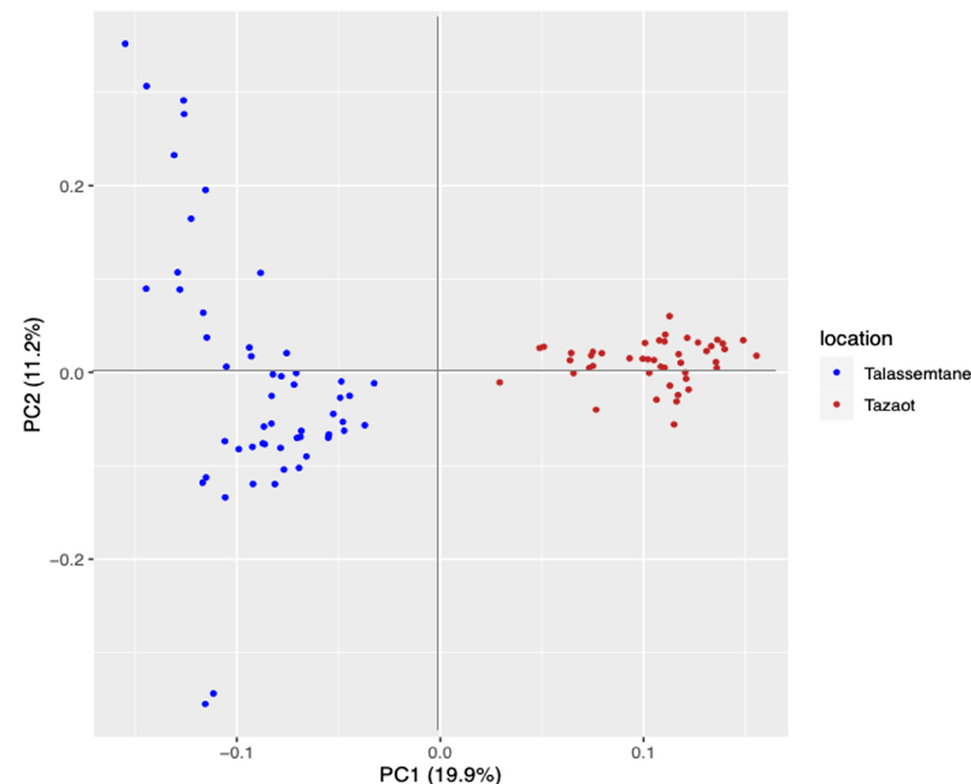
Figure 4. PCA results obtained comparing the two Abies marocana study sites. Talassemtane site is colored in blue, and Tazaot in brown. The axis of the two principal components (PC) and the percentage of variance explained by each axis are shown.